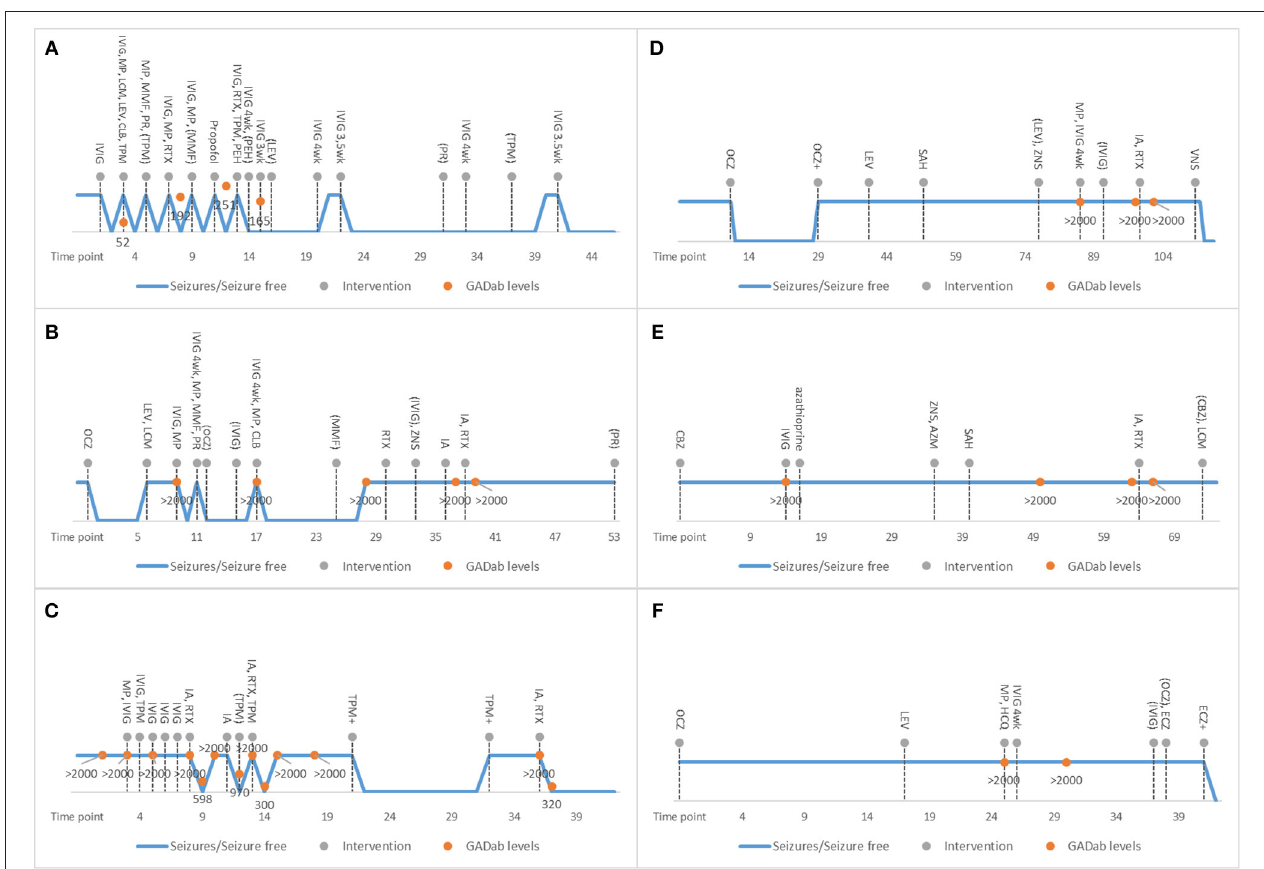
FIGURE 1 | Individual characteristics of treatment responses and therapies provided in the studied GAD-epilepsy patients are shown. X-axis shows the time-points in months starting from symptom onset. The blue line displays seizures / no seizures. Dotted lines refer to the interventions. Orange dots are GAD65 antibody levels. Discontinuation of therapies is shown in parenthesis. 4 wk means 4-week intervals. Patient 1 (A) responded well to early initiation of immunotherapy. With patient 2 (B) , there was longer delay before immunotherapy and she continued to experience seizures even after several AED and immunotherapy trials. However, her